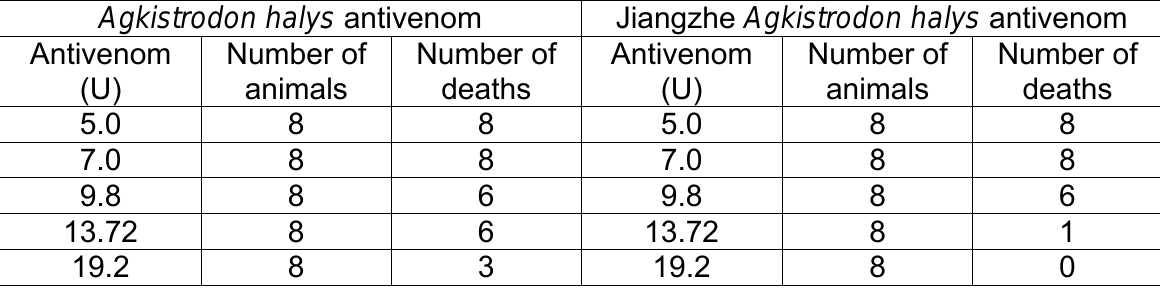
) of Agkistrodon halys and Jiangzhe 50